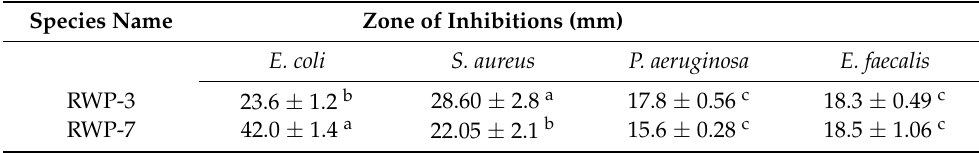
Table 1. Antibacterial activity by well diffusion method.